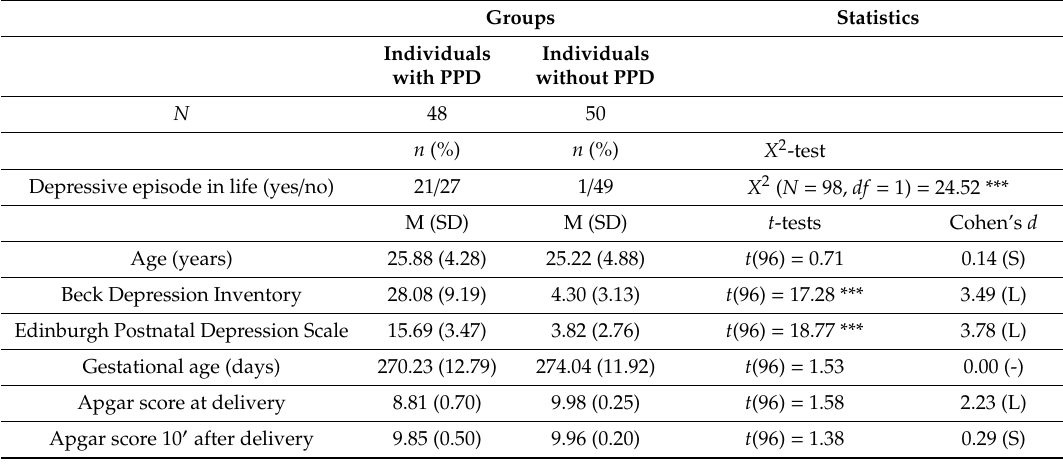
Descriptive and inferential statistical indices of sociodemographic, depression- and delivery-related information, separately for participants with post-partum depression (PPD) ( N = 48), and without post-partum depression ( N = 50).